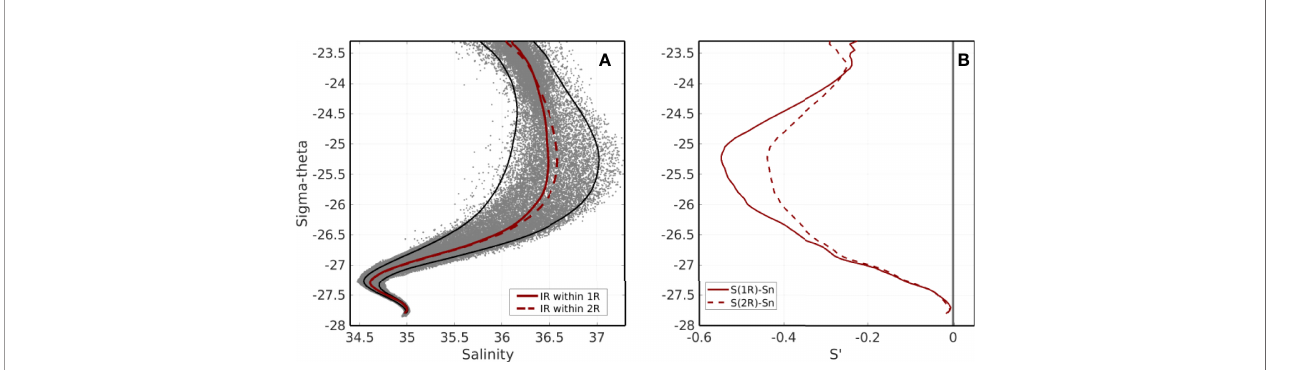
FIGURE 8 | (A) S- s q diagram for all IR + OR pro fi les within the searching area (gray dots), from the subset containing observations with both T and S values. The black lines are the S S (left) and S N (right) curves, respectively. The red lines are the average salinity (S) for the mean ring, computed with all IR pro fi les located within 1R (solid) and 2R (dashed) from the ring center. One standard deviation (not shown) is about 0.5 for s q = 25.5 kgm -3 , decreasing for lower and higher densities. (B) Salinity anomaly, in density space, of the mean ring with respect to the expected salinity of North Atlantic waters (S N ), for the IR pro fi les located within 1R (solid) and 2R (dashed) from the ring center.